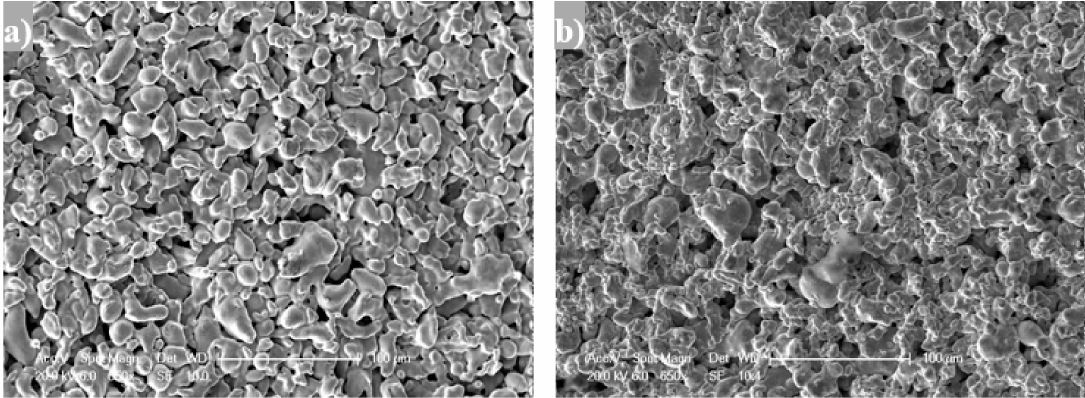
Figure 1. SEM images of PSS supports with diverse commercial media grades: ( a ) 0.1 µ m and ( b ) 0.2 µ